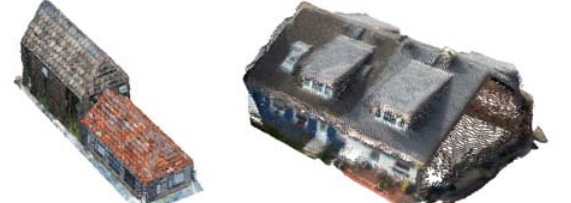
Figure 1. Colored synthetic point cloud (left) and colored point cloud for a building from the Heligoland dataset (right)